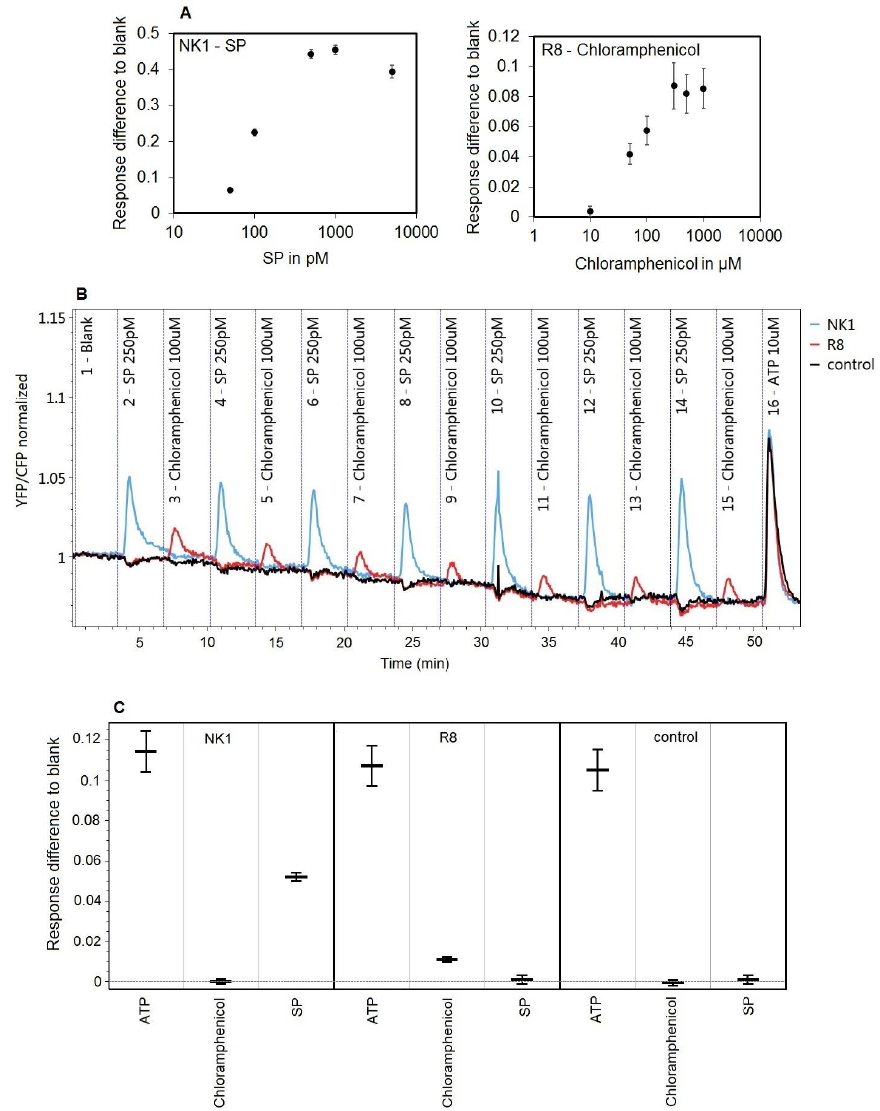
Figure 5. Repeated challenges of two distinct GPCRs by a series of samples. ( A ) Dose-response